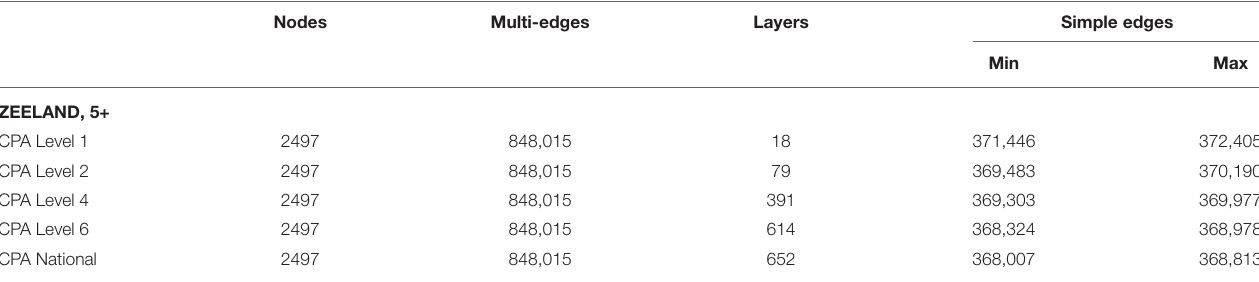
TABLE 3 | Network statistics for the multi-layer complementary ensembles over 25 realizations, simulating trade-compatible relationships among companies with 5 + employees within Zeeland province. Nodes Multi-edges Layers Simple